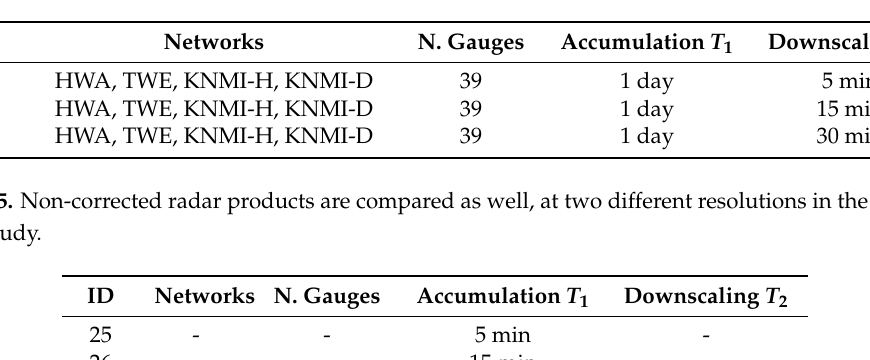
Table 4. Daily accumulations are calculated with all the available rain gauges, including the daily ones in the Dutch case study.